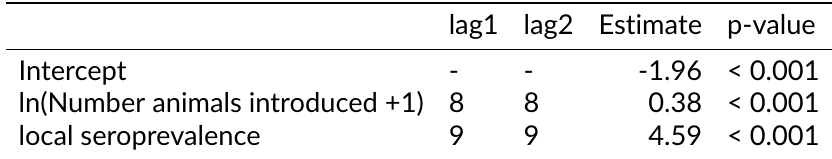
Figure 5 – AIC values associated with logistic models of the association between 2 vari- ables and the probability of seroconversion between 2 tests. Each coloured row repre- sents the end of the interval that is closest to the current month and each column the end of the interval that is the furthest in the past. For example, the line at the bottom rep- resents intervals that end on the current month: the first column is for the interval that started and ended on the current month (length of one month) and the last column is for the interval between 24 months ago and the current month. The variable evaluated on the left-hand side panel is the sum of the ln(number of animals introduced + 1) between lag1 and lag2. The variable evaluated on the right-hand side panel is the max of the local seroprevalence between lag1 and lag2. Table 2 – Results of the final logistic model of the probability of seroconversion between consecutive tests. The risk factors retained in the model were the logarithm of the num- ber of animals introduced in the herd 8 months before seroconversion and the local sero- prevalence 9 months before